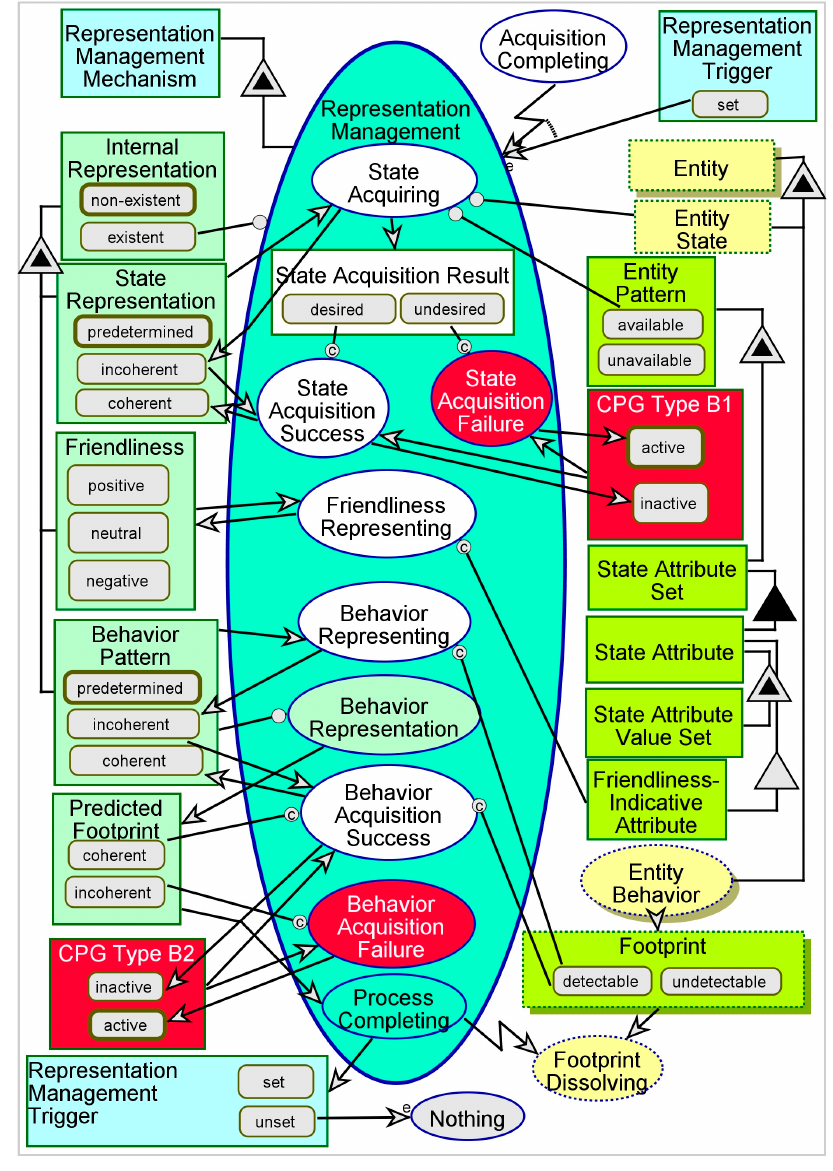
Figure 5. The Representation Management process.